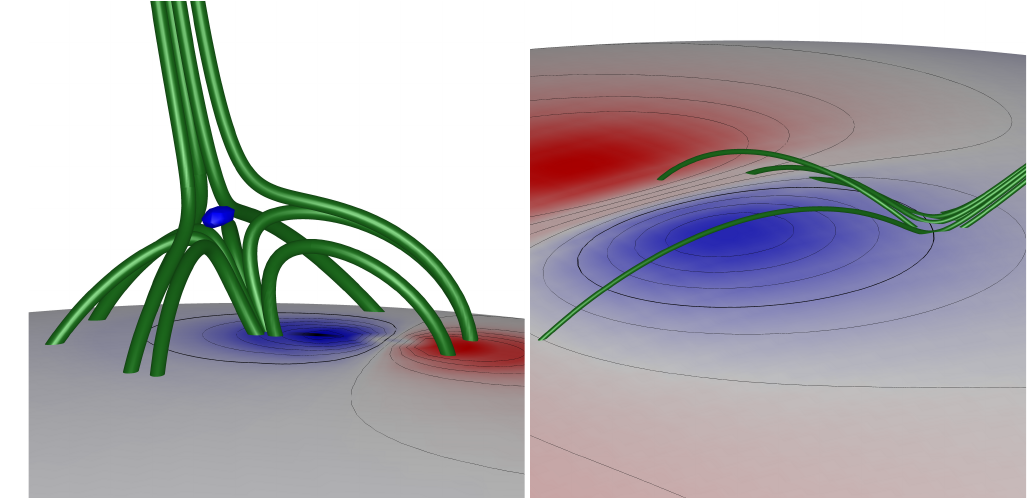
Fig. 2. A magnetic null point (left) and a bald patch topology (right). Red shading indicates positive, blue shading negative polarity of the radial magnetic field strength, B r . The thick black lines indicate the polarity inversion lines (PILs), the blue bubble marks the location of the magnetic null point, and some magnetic field lines are drawn in green. For a bald patch topology, the magnetic null lies below the surface, and the field lines are parallel to the surface and concave up along part of the PIL.